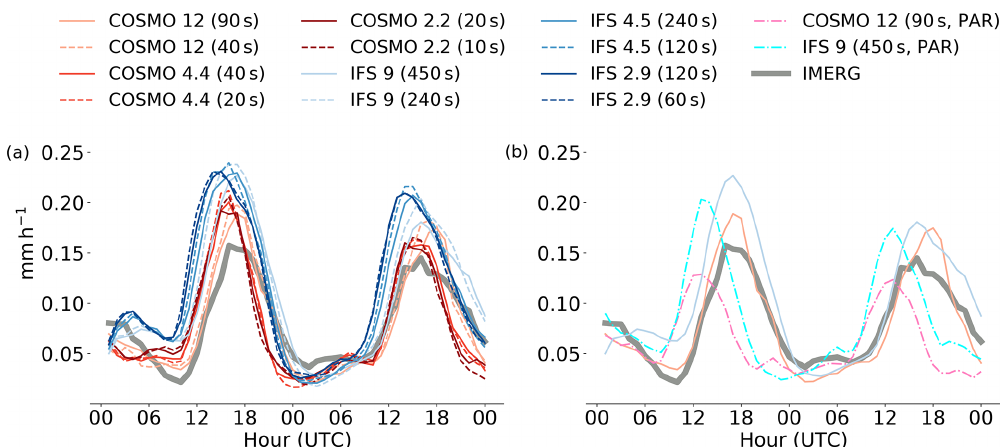
Figure 5. Diurnal cycle of precipitation over land in the European domain from 29 May 2018 01:00UTC to 31 May 2018 00:00UTC. The plot shows accumulated hourly precipitation, meaning that at 29 May 2018 01:00UTC it shows the precipitation accumulated from 29 May 2018 00:00UTC to 29 May 2018 01:00UTC. Panel (a) shows all runs with explicit deep convection and two different time steps per spatial resolution. The results from the runs with the shorter time step are represented by the dashed lines. Panel (b) shows the coarser runs with parameterized (PAR) and with explicit deep convection. Both panels also show the values from the Integrated Multi-satellitE Retrievals for GPM (IMERG) dataset for our domain. Table 2. Mean precipitation per 48h in the different domains. The bold numbers represent the reference values of the respective domain that have been used to calculate the differences in